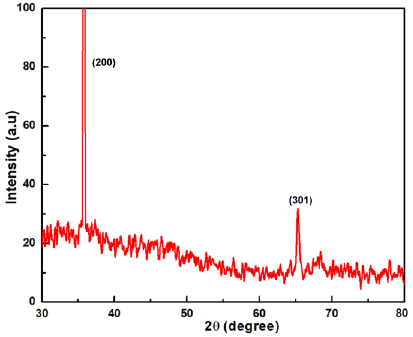
Figure 3. X-ray diffraction (XRD) spectrum of the free-standing Sn nanostructure arrays.